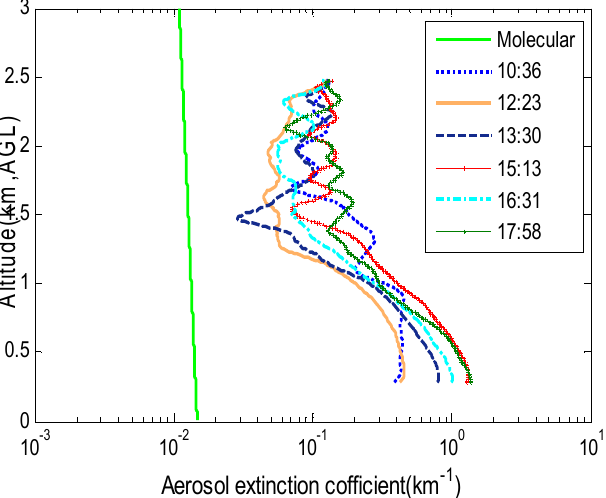
Figure 11. The extinction coefficient profiles on 3 June 2011, in Qingdao (data logged in LST).